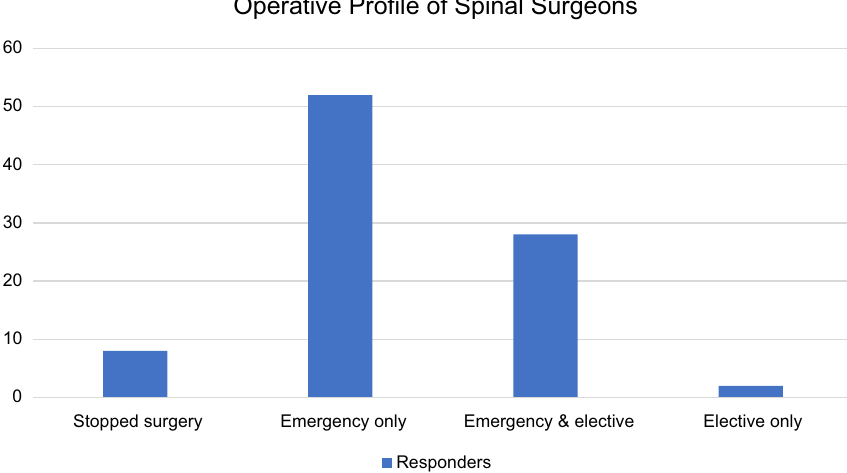
Figure 2. Effect of COVID-19 on pro fi le of surgical practice among spine